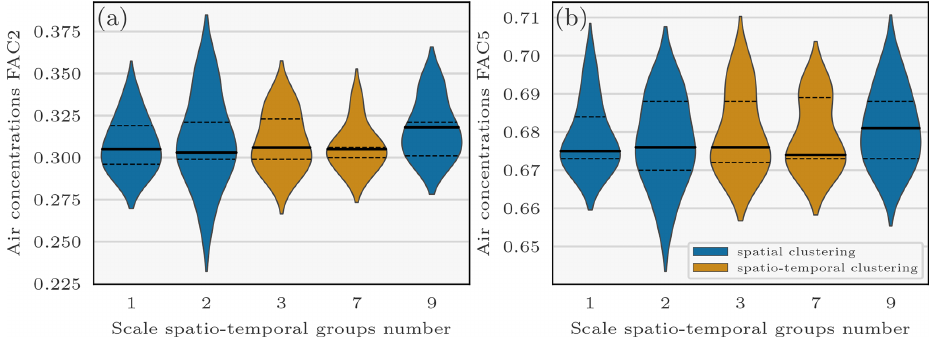
Figure 6. Violin plots of the air concentration FAC2 and FAC5 scores against the observation error scale parameters’ spatio-temporal groups number. Points composing the violin plots consist of the best FAC2 and FAC5 scores of 44 sampling datasets using diverse configurations of likelihoods and thresholds (log-normal, log-Laplace, and log-Cauchy) chosen according to Dumont Le Brazidec et al. (2021). The horizontal segments within the violins represent (from bottom to top) the respective first, second, and third quartiles. The chosen numbers of spatial and spatio-temporal clusters are only a selection for the sake of clarity.